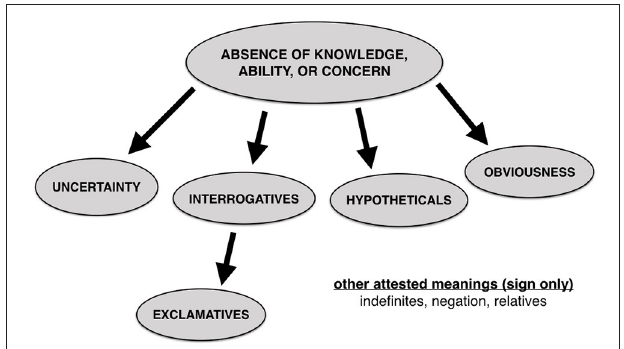
FIGURE 4 | Proposed meaning network connecting the most broadly attested meanings of the palm-up epistemic in gesture and sign, with a core meaning of absence of knowledge, ability, or